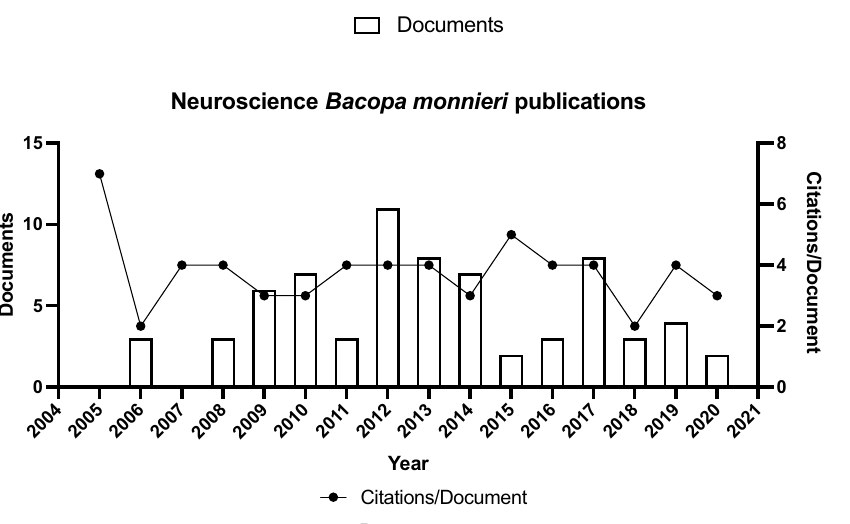
specific timeline, using the search terms, BacoMind, Bacognize, KeenMind, Bacopa monnieri , Bacopa monniera , Brahmi, water hyssop, and thyme-leaved Graciela. From the articles found in these searches, the clinical trials were selected for further evaluation. Non-double-blind placebo-controlled studies and studies using B . mon- nieri in a formulation combined with other herbs, such as Ginko biloba , or at a dose less than 200 mg/day were